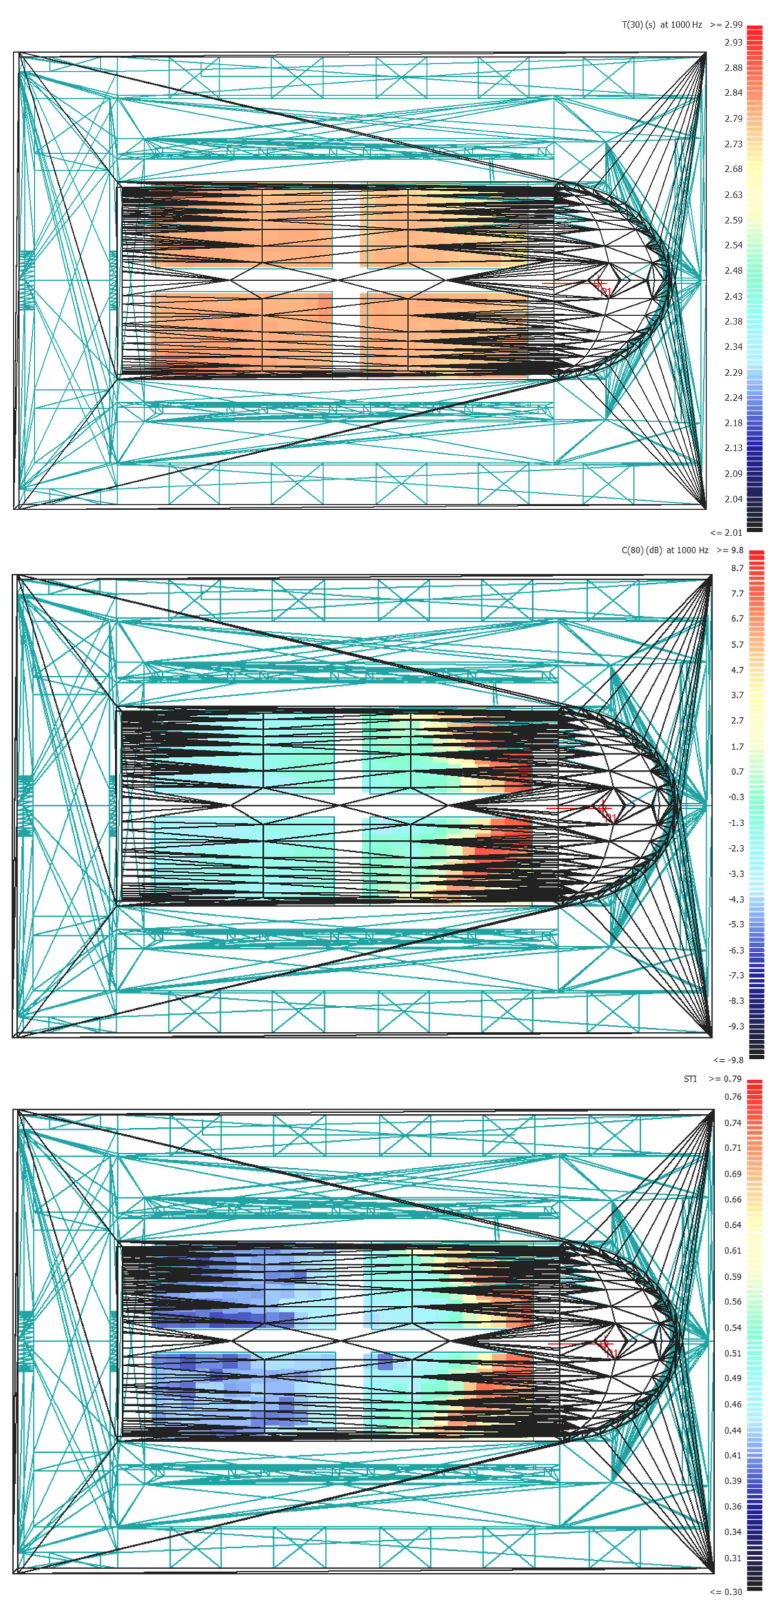
Figure 9. Color maps at 1 kHz of the T 30 , C 80 , and STI in the configuration with the audience and the perforated transparent banners (the maps only cover the area where the audience